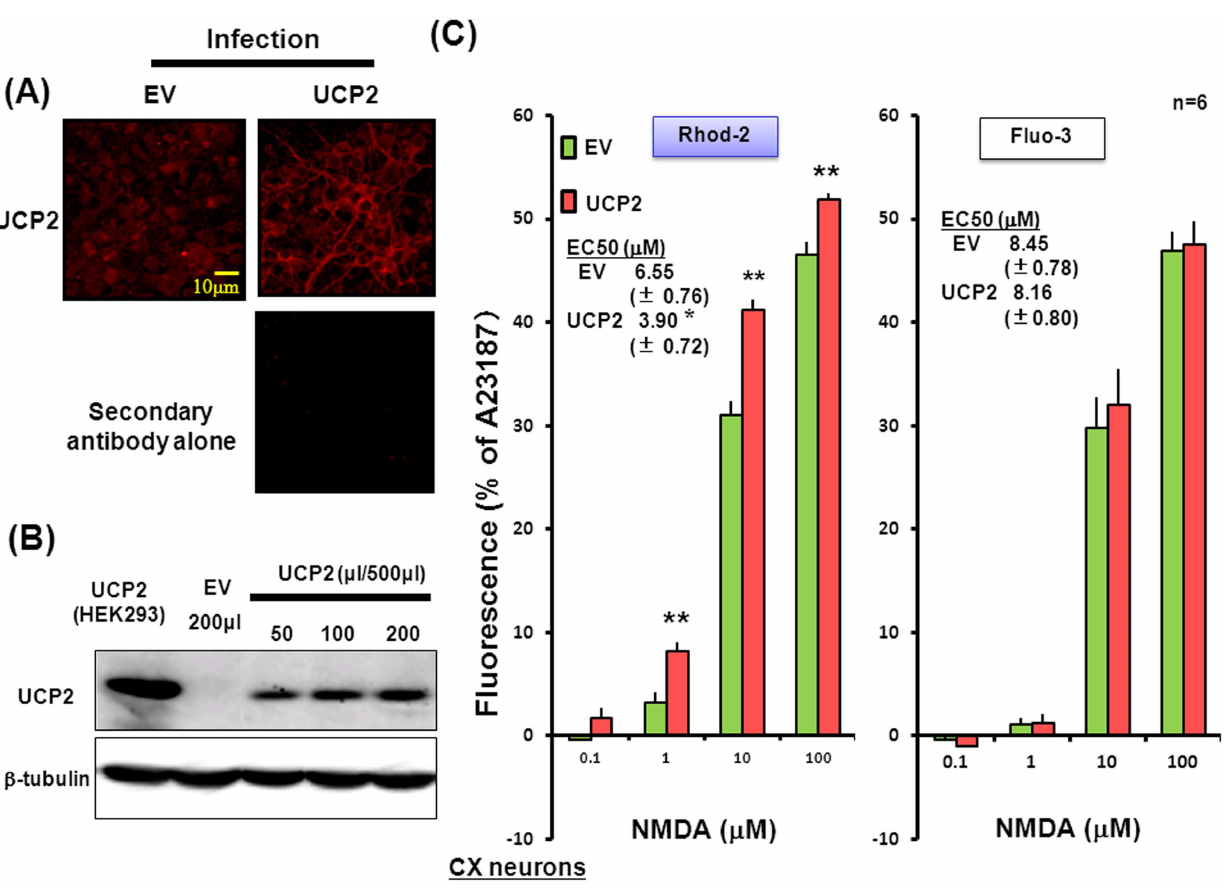
Figure 3. Lentiviral overexpression of UCP2 in cultured neurons. Murine neocortical neurons were cultured for 4 days, followed by infection with lentiviral UCP2 or EV expression vector at 50 to 200 m l/500 m l and subsequent further culture for an additional 4 days. Cells were then subjected to determination of UCP2 protein expression on (A) immunocytochemistry and (B) immunoblotting analyses. Cells were also loaded with either (C) Rhod-2 or (D) Fluo-3, followed by cumulative addition of NMDA at concentrations of 0.1 to 100 m M. Values are percentages over the maximal fluorescence by A23187 in 6 independent determinations. **P , 0.01, significantly different from each control value obtained in cells with EV alone. Statistical significance was determined according to the Students’ t